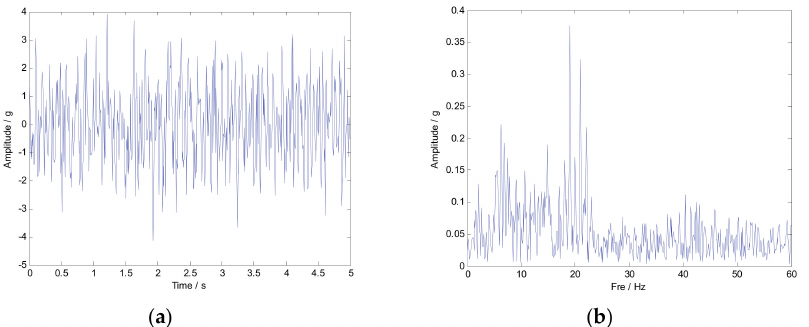
Figure 2. Time-domain waveform of signals x 1 and x 2 . ( a ) The amplitude modulation (AM)-frequency modulation (FM) signal x 1 ; ( b ) The FM signal x 2 .